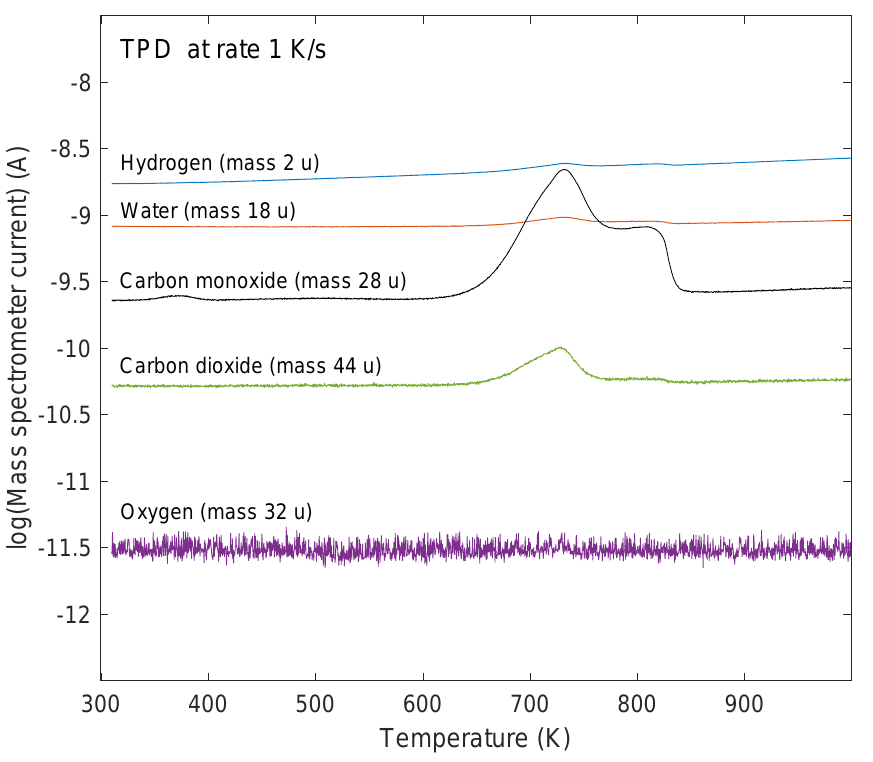
Figure 6. TPD spectra for mass 2, 18, 28, 32, and 44 u after exposure to 200 L oxygen at 675 K of a saturated graphene/Ru(0001)